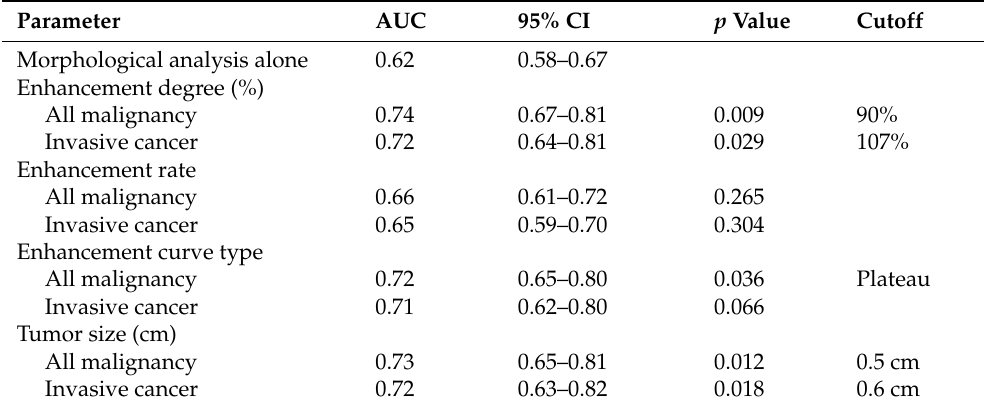
Table 2. Receiver operating characteristics curve analysis of parameters for differentiating benign and malignant breast lesions.